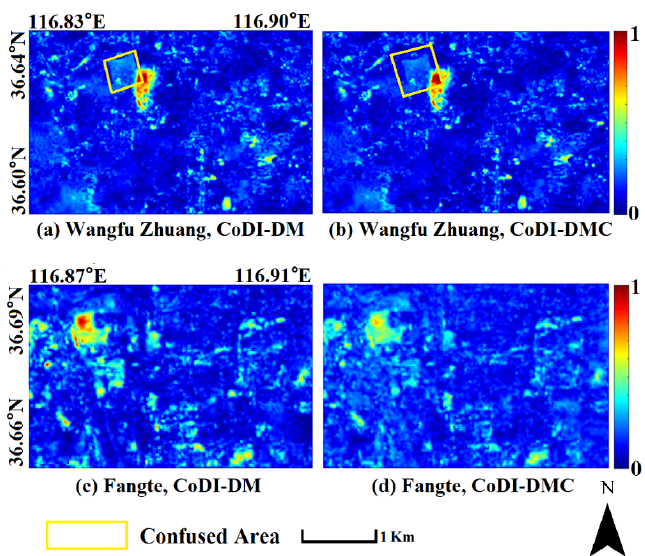
Figure 7. Combined difference images including ( a ) CoDI-DM and ( b ) CoDI-DMC at Wangfu Zhuang Station and ( c ) CoDI-DM and ( d ) CoDI-DMC at Fangte Station. Note: the CoDI-DMs combine by the DVDI and MVDI with equal weights, whereas the CoDI-DMCs combine by the DVDI, MVDI and CDI with equal weights. The CoDI-DMs around Wangfu Zhuang Station and Fangte Station are shown in Fig- ure 7a and Figure 7c, respectively. According to the statistics, the mean and variance of the CoDI-DM in Wangfu Zhuang Station and Fangte Station reach 0.1211, 0.0092 and 0.1641, 0.1410, respectively. The mean values were higher than those in the CoDI-LEWs but lower than those in the DVDIs. There were no rules to follow with respect to the var-